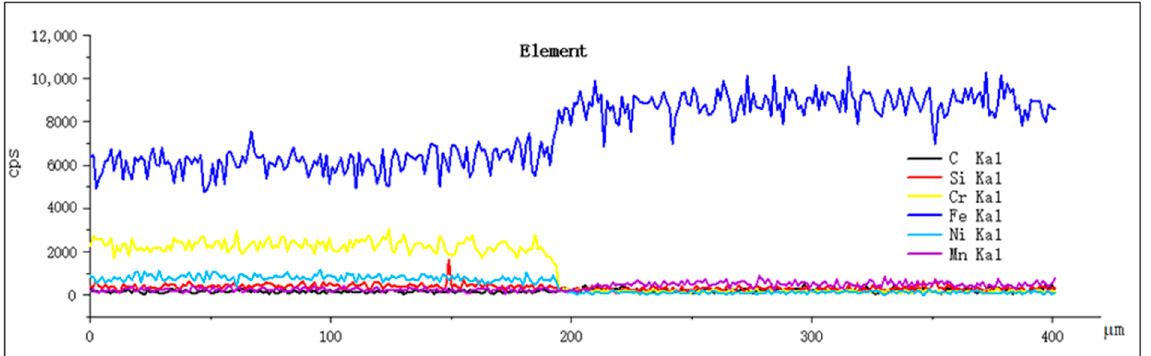
Figure 7. Diffusion diagram of elements at the interface between the cladding layer and the substrate.